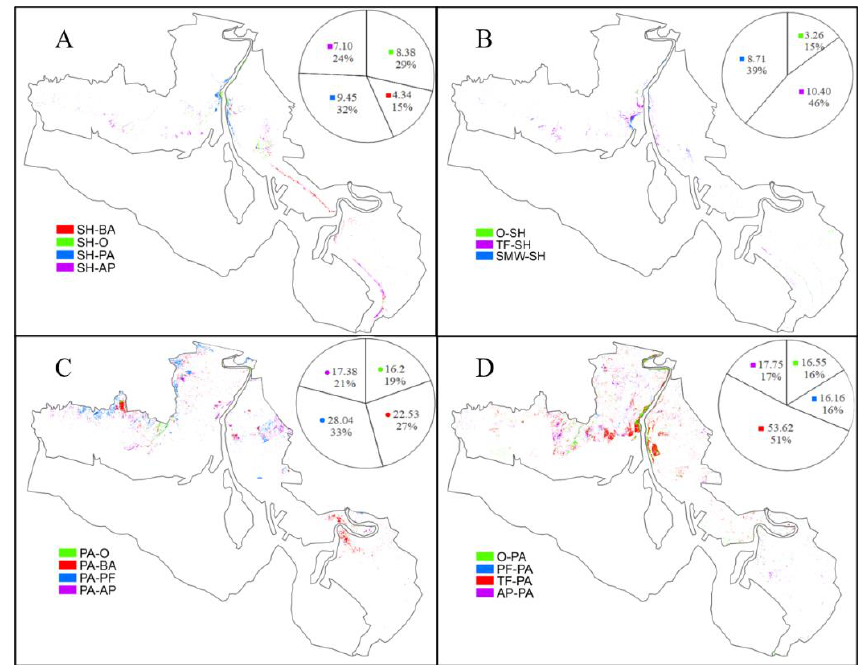
Figure 7. The spatial distribution, quantity (km 2 ), and percentage of areal changes in seepweed and reeds. Seepweed converted to other cover types ( A ); other cover types converted to seepweed ( B ); reeds converted to other cover types ( C ); and other cover types converted to reeds ( D ). SH: seepweed; BA: built-up area; PA: reed field; PF: paddy field; TF: tidal flats; SMW: shallow marine water; AP: aquaculture ponds; O: other covers.